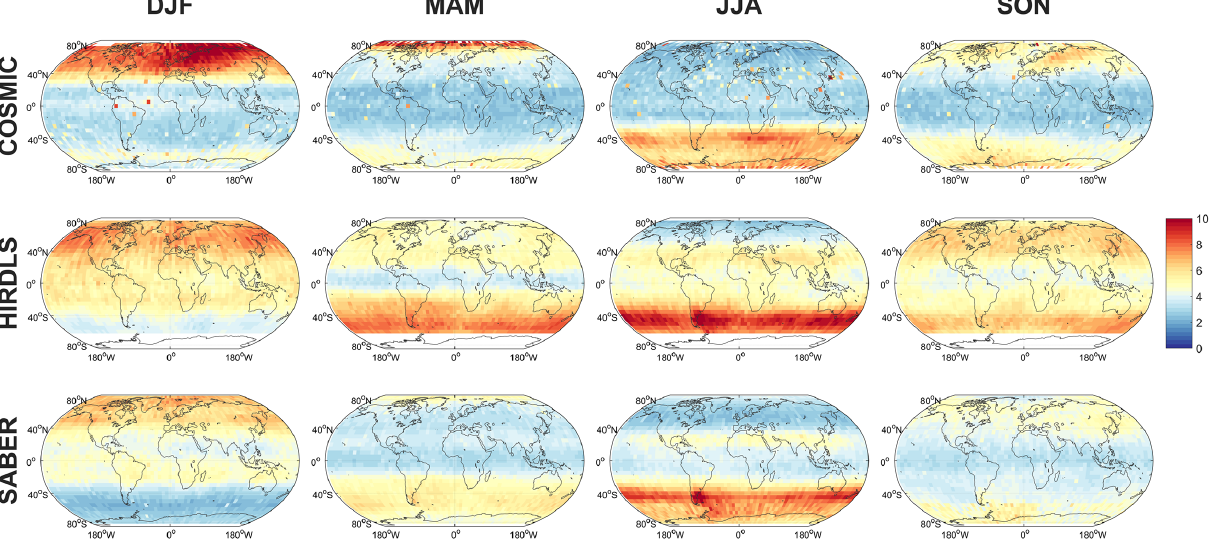
ing the COSMIC sampling pattern at 50 km in altitude. Ob- servational datasets are shown at the right of each panel. Thick blue lines show the best agreement between a pair of datasets, and thin red lines the worst. In each case, these